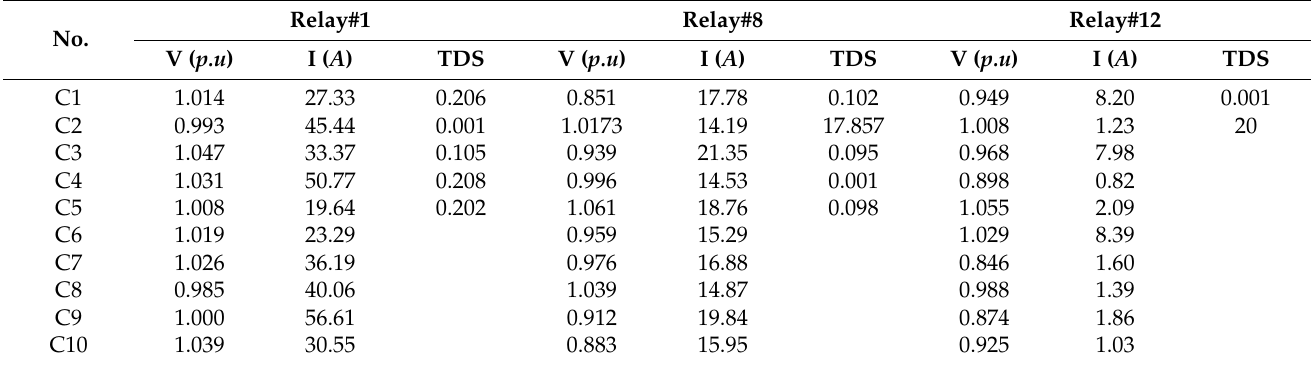
Table 5. Centroids for relays under investigation.